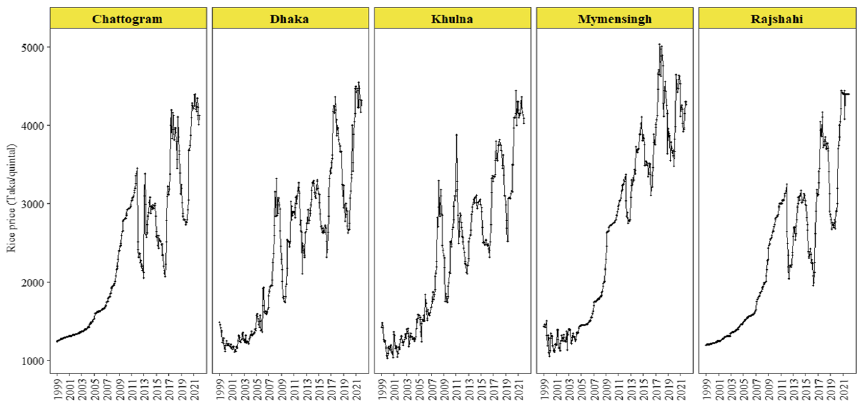
Table 1 Descriptive statistics of major rice markets in Bangladesh Statistic